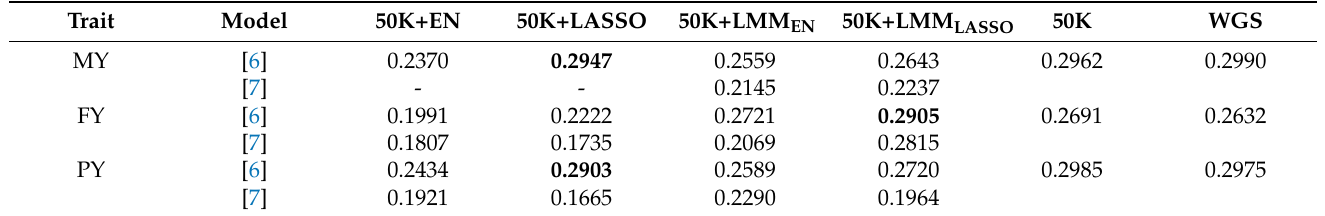
Table 5. Prediction accuracy of GS using 50K SNP chip data combined with selected SNPs from WGS data.